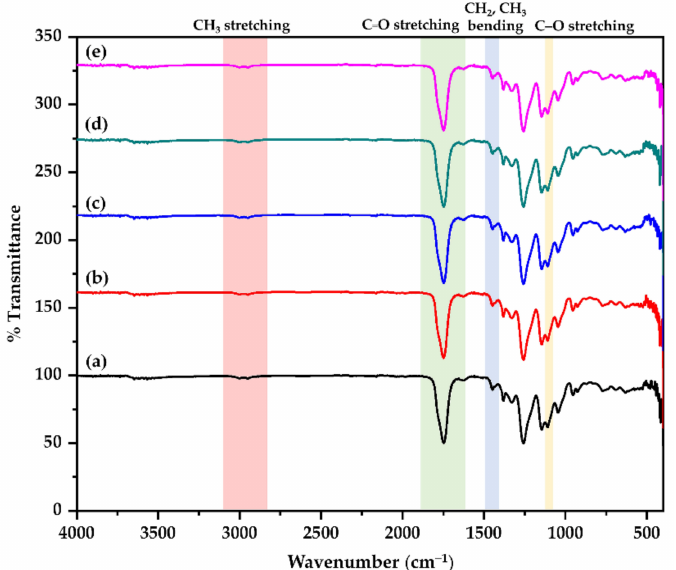
Figure 1. FT-IR spectra of poly(methylenelactide) with different amounts of AIBN (5, 10, 15, 20, and